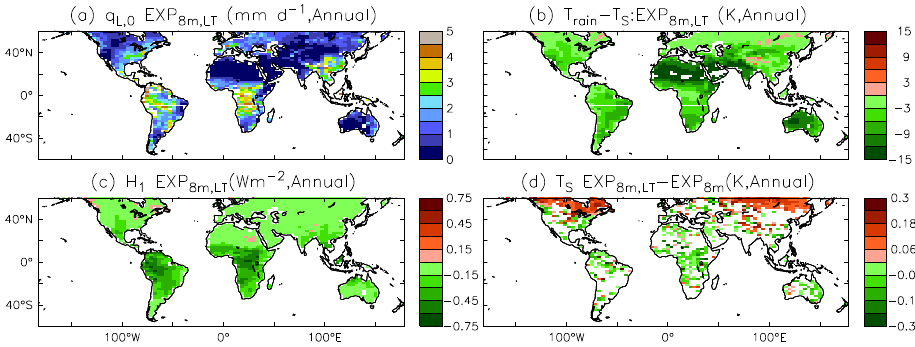
Figure 7. (a) Liquid water flux at surface, (b) difference between rain and surface temperature, (c) heat fluxes by convection at surface for EXP 8m , LT (Table 4), and (d) differences in surface temperature due to the heat transferred by rain and water into the soil (differences between EXP 8m , LT and EXP 8m ). All values are annual